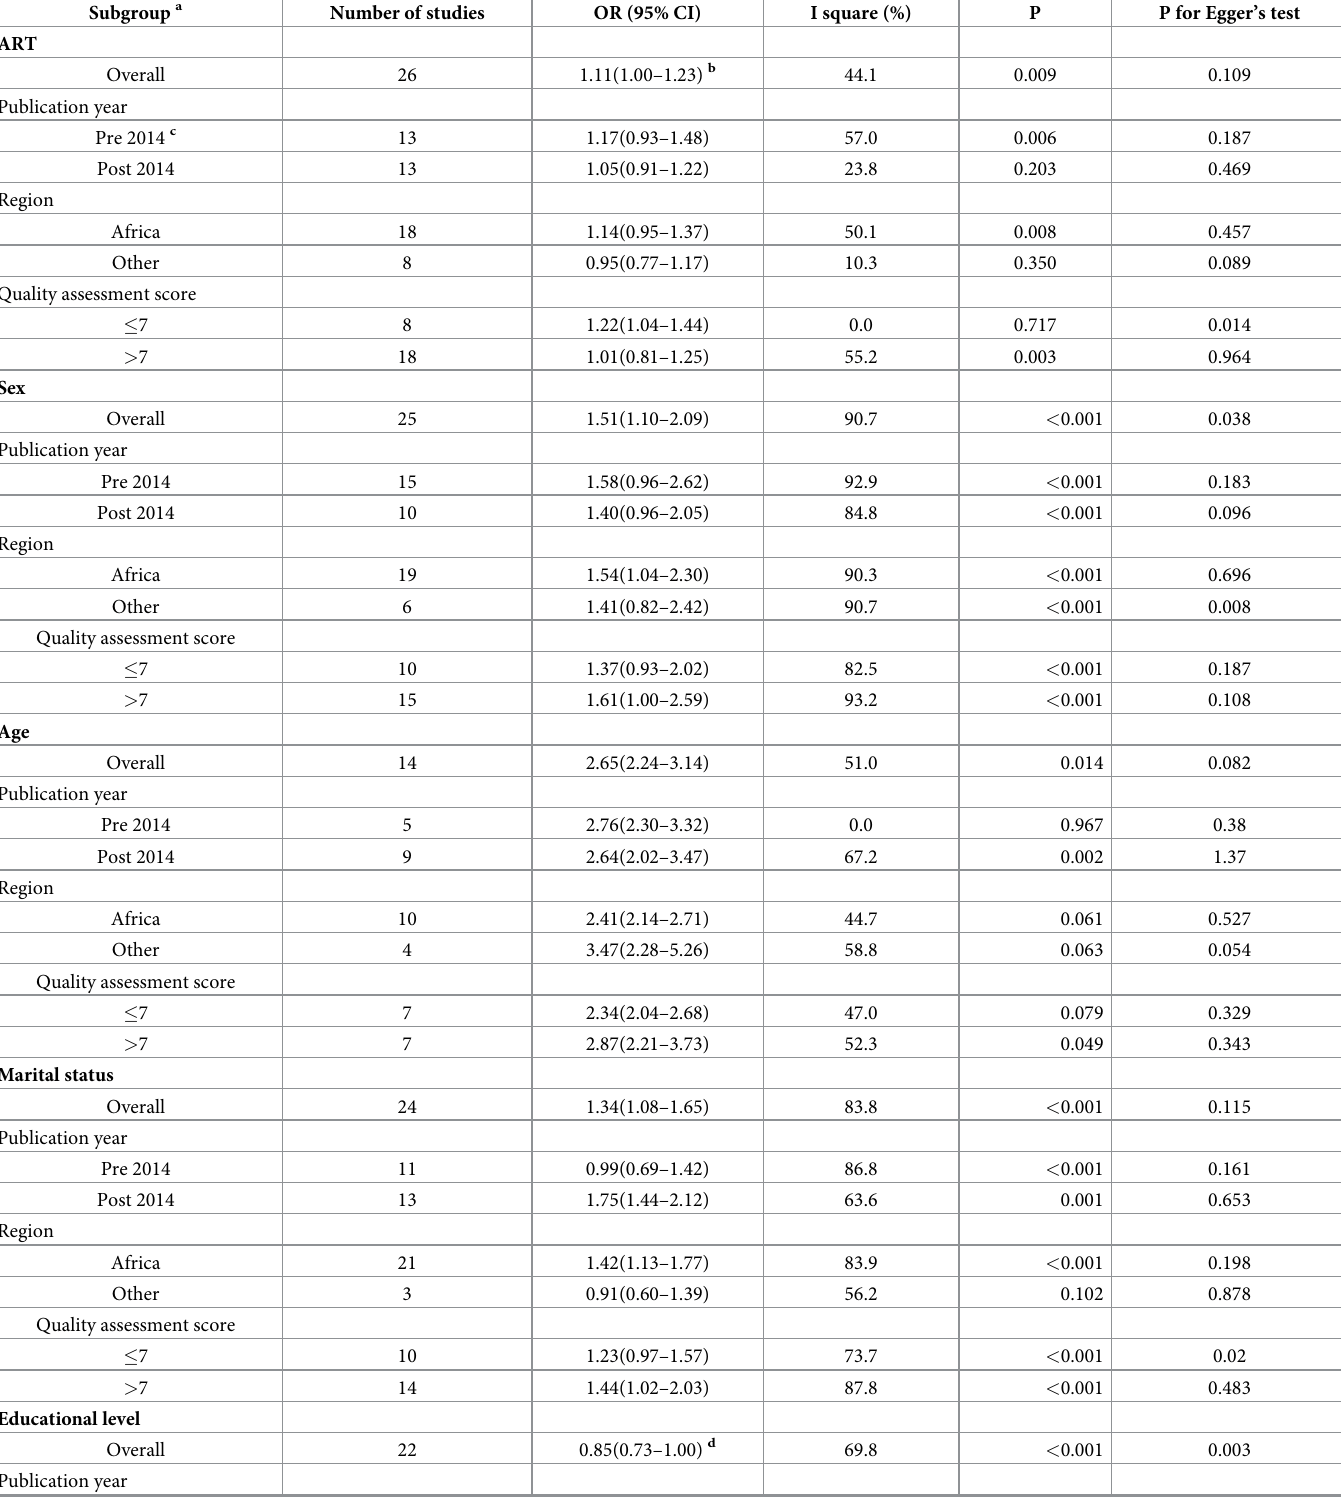
Table 2. The results of the meta-analysis, the heterogeneity test, and publication